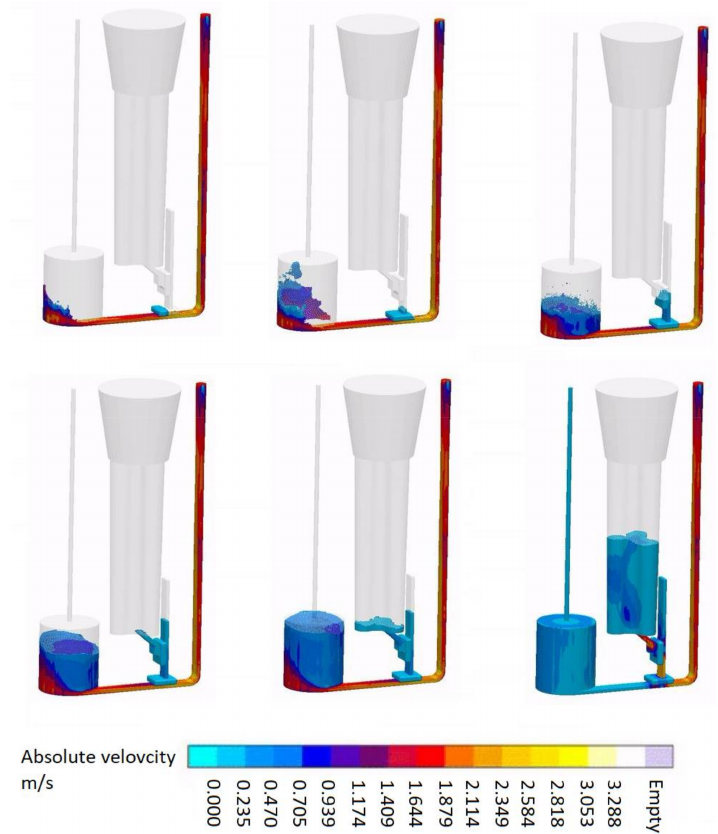
Figure 11. Combined gating system design; filling time 10